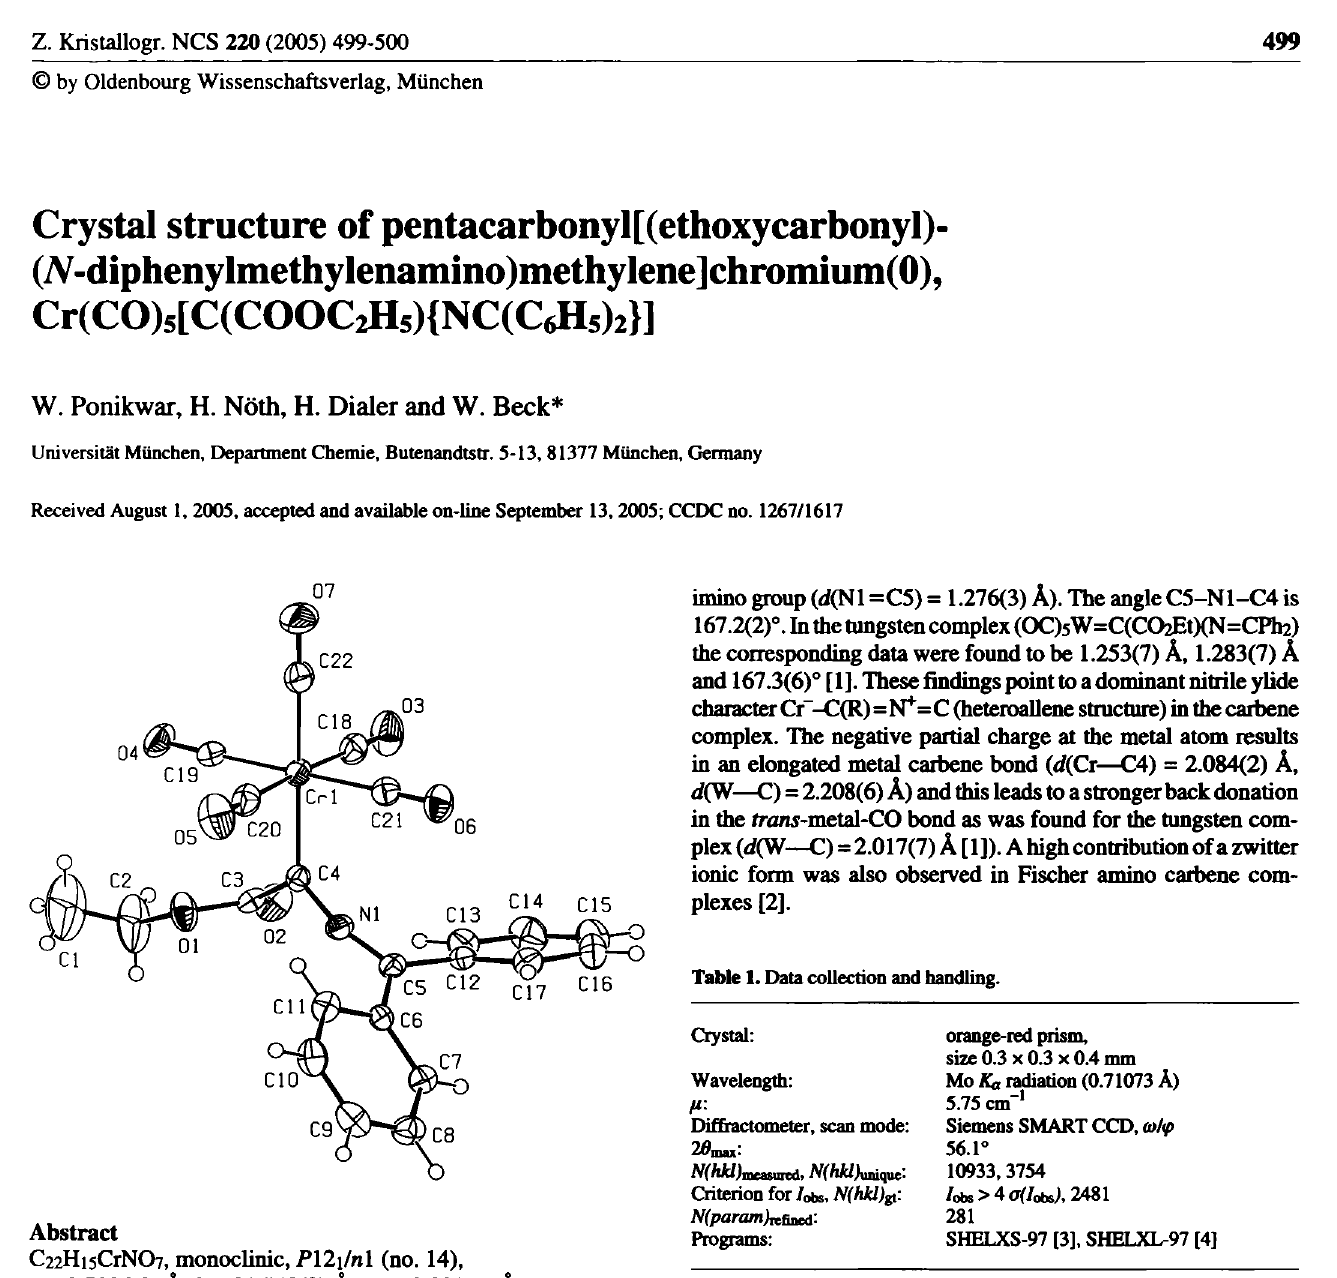
Table 2. Atomic coordinates and displacement parameters (in A 2